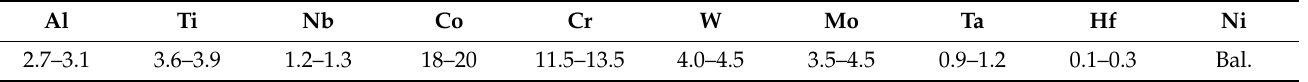
Table 1. The chemical compositions of the novel P/M superalloy (wt.